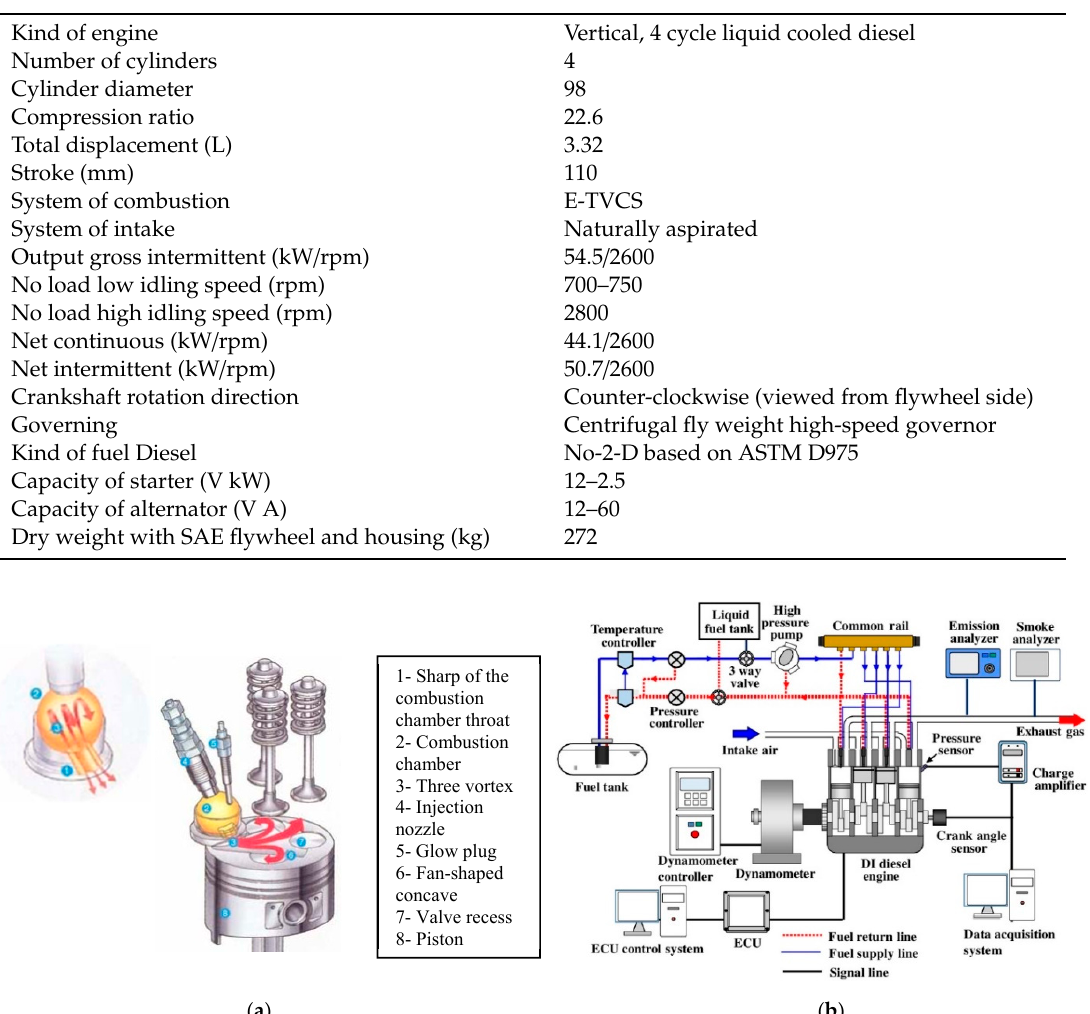
Table 2. Engine specifications of Kubota V3300.